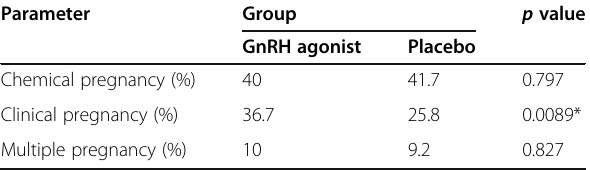
Table 3 Pregnancy outcome analysis of the studied